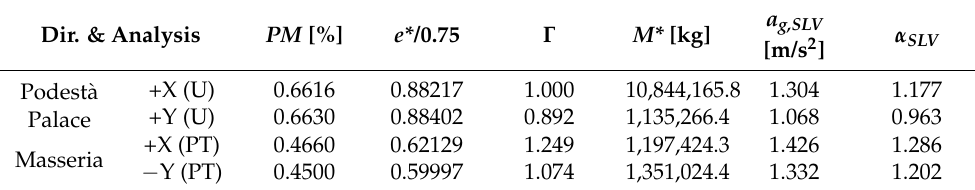
Table 5. Summary of the seismic verification results.